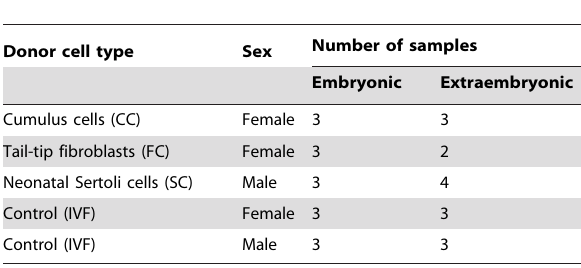
Table 1. List of samples from E6.5 cloned embryos analyzed by